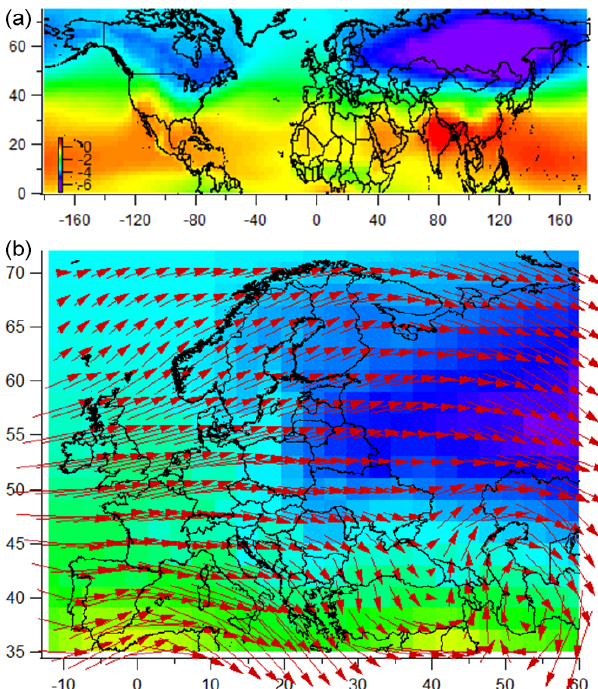
Figure 11. Long-term mean (2004–2014) for June–August total column (cid:49) XCO 2 (in ppm) from CT2015 (a) in 3 ◦ × 2 ◦ spatial reso- lution, and detail for Europe overlaid with pressure-weighted (1000 to 500hPa) mean wind vectors for the same period (b) . The color scale is the same as in Fig. 9a, which is scaled to reflect 6ppm dif- ference of XCO 2 to compare with satellite retrievals from Reuter et al. (2014, their Fig.